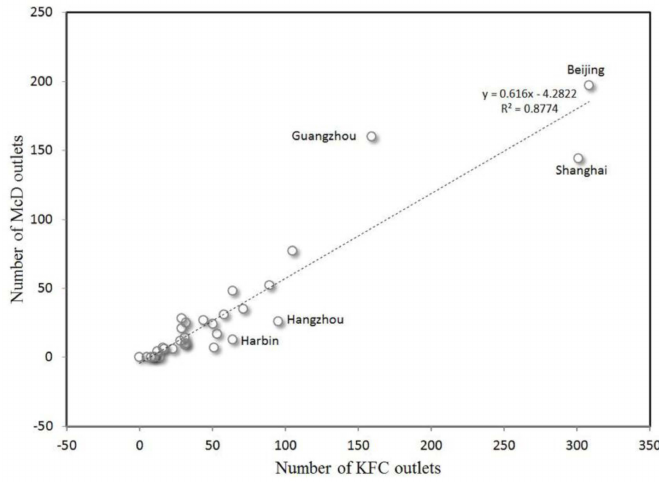
Figure 2. The comparative plot of KFC and McDonald’s outlets in Mainland China’s major